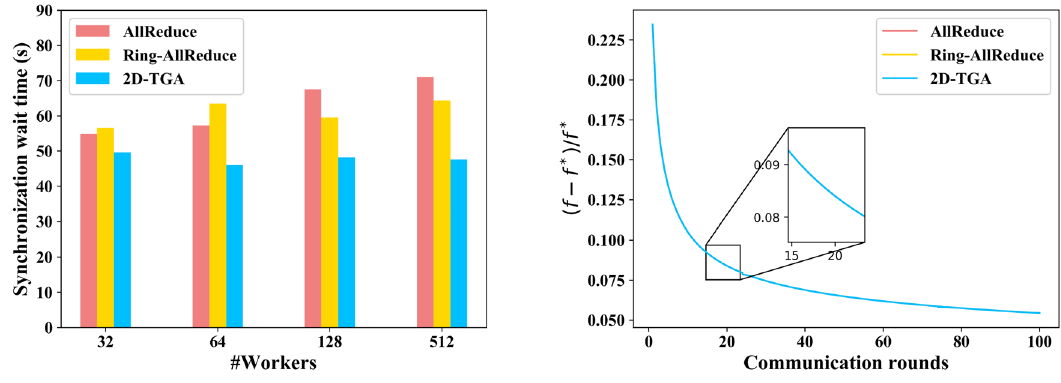
Fig. 6 Experimental results of webspam dataset